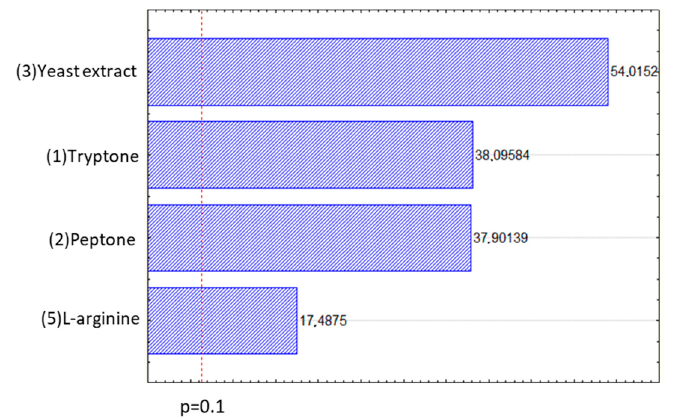
Figure 4. Pareto diagram for the estimated effect of each variable of the Fractional Factorial Design on ethanol production—P EtOH —in the syngas fermentation by Clostridium carboxidivorans . The point at which the effects estimates were statistically significant (at p = 0.10) is indicated by the broken vertical line.